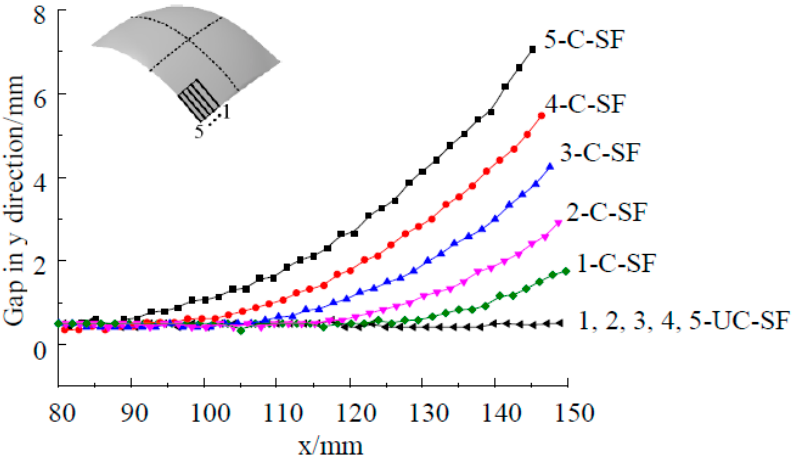
Figure 10. Gap between final sheet metal and die in different positions.